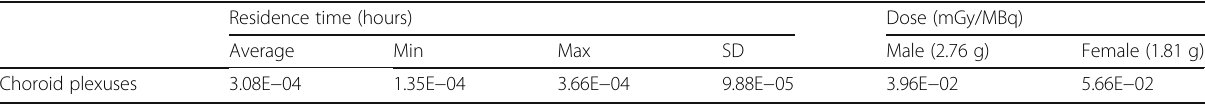
Table 3 Dosimetry assessment in choroid plexuses. The mass of the choroid plexuses was estimated assuming a cylindrical geometry based on dimensions reported by Kuruoglu et al. for both male and female subjects